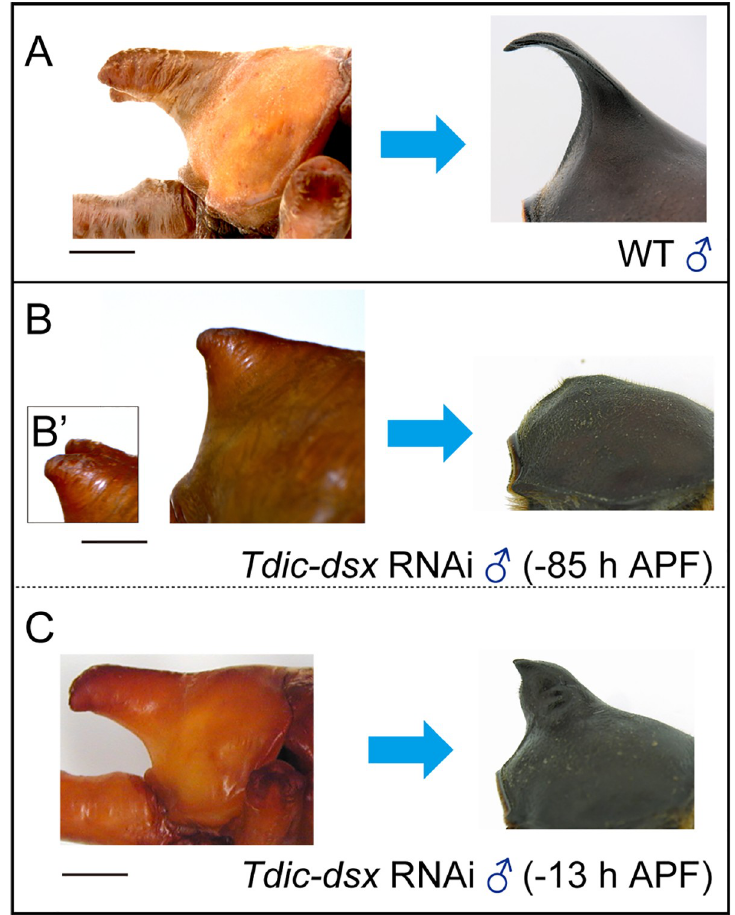
Fig 7. Horn formation phenotypes induced by Tdic-dsx RNAi at late prepupal stages. (A-C) Thoracic horn remodeling during pupal-adult development in males. (A) A wild type male thoracic horn. (B) Almost complete reduction of a thoracic horn with an early Tdic-dsx RNAi treatment (-85 h APF). (B’) dorsolateral view. (C) Unremodelled thoracic horn formed by a late Tdic-dsx RNAi treatment (-13 h APF). APF, after puapal-chamber formation. Scale bars are 5